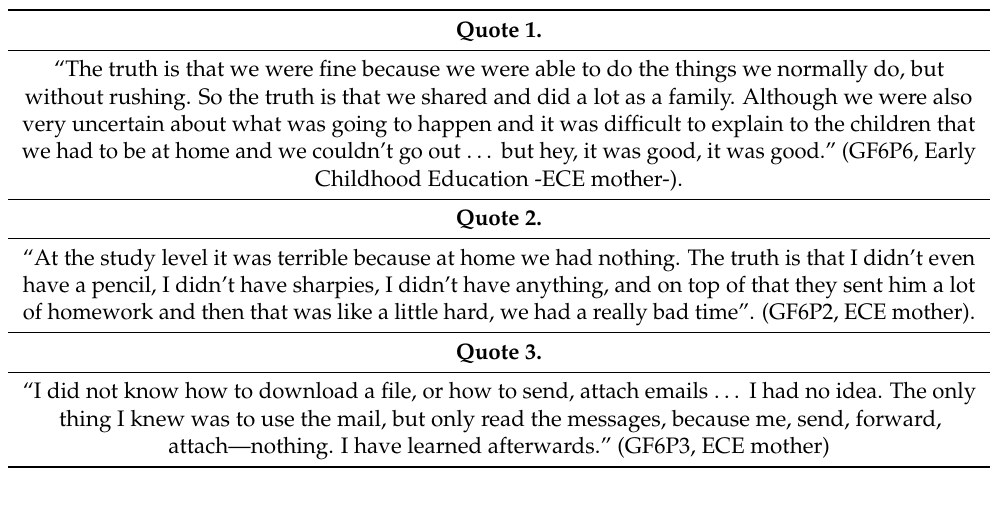
Table 8. Focus Group Families